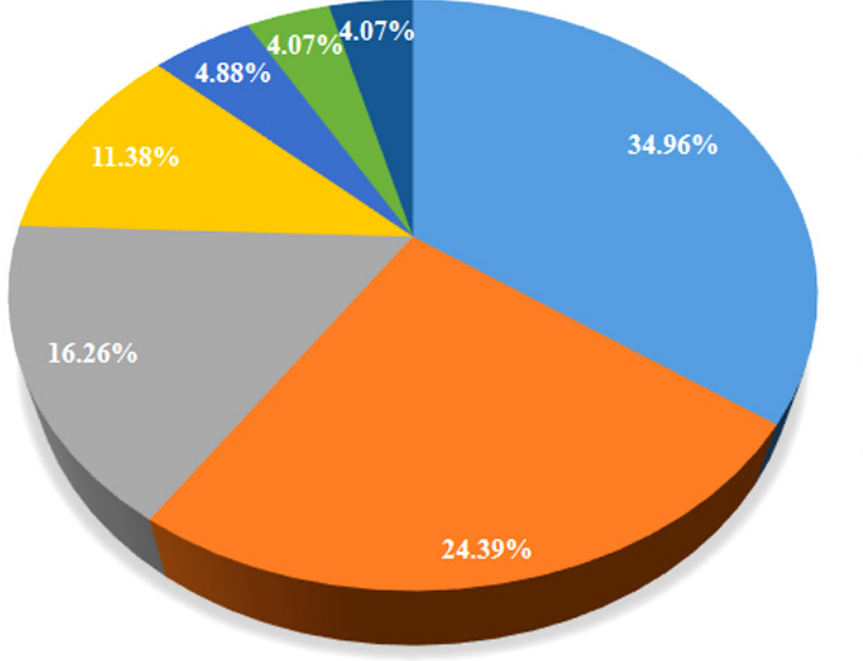
Figure 3. Classification of proteins encoded by the target genes.